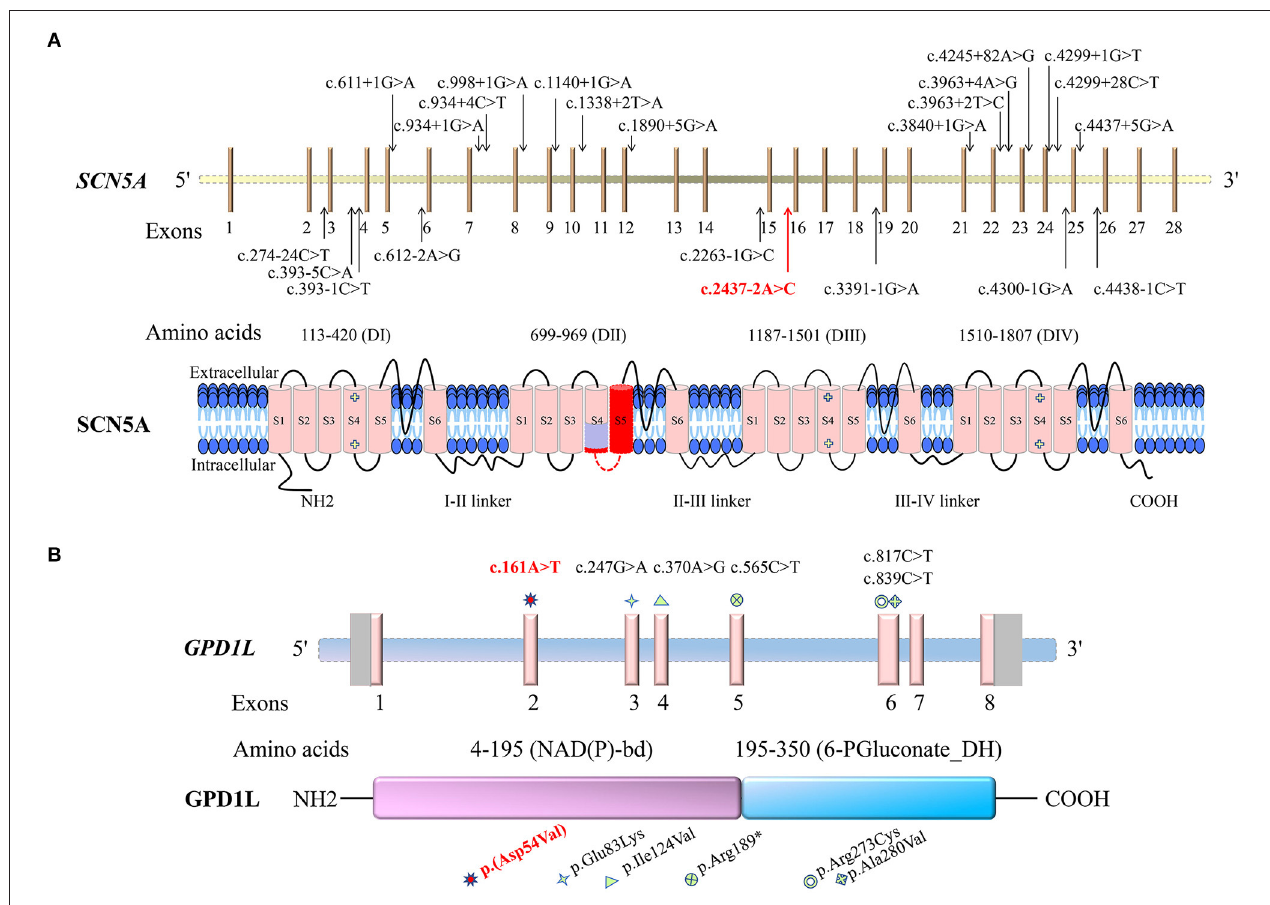
FIGURE 6 | Schematic representations of the sodium voltage-gated channel alpha subunit 5 gene ( SCN5A ) and the glycerol-3-phosphate dehydrogenase 1 like gene ( GPD1L ) and the encoded proteins, as well as the identified variants. Variants identified in this study are indicated by red colors. (A) The Brugada syndrome-1-related single nucleotide substitutions affecting splicing are shown in the SCN5A gene. SCN5A consists of four putative transmembrane domains (DI-DIV), with six transmembrane segments (S1–S6) for each section. The light purple-colored region on SCN5A is the segment encoded by the first 15 nucleotides of exon 16, and the dark red is encoded by the 16–141 nucleotides of exon 16. (B) The GPD1L gene variants related to Brugada syndrome-2 and sudden infant death syndrome are shown. GPD1L contains the glycerol-3-phosphate dehydrogenase (GPD) motif [nicotinamide adenine dinucleotide (phosphate)-binding domain, NAD(P)-bd] and 6-phosphogluconate dehydrogenase C-terminal domain-like (6-PGluconate_DH).